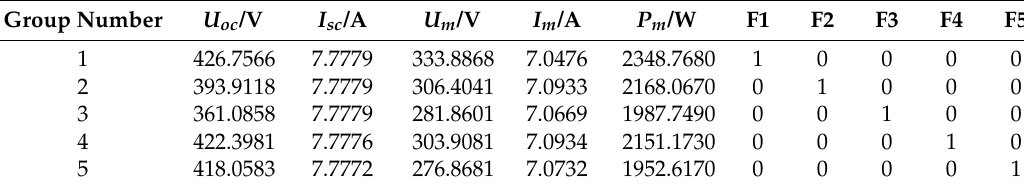
Table 13. PV array fault diagnosis samples.